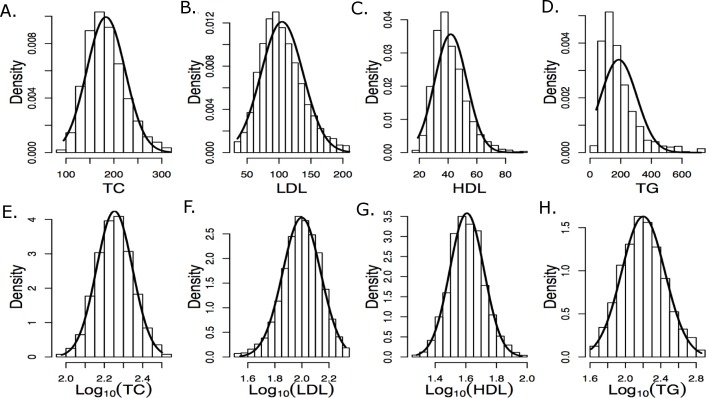
Histograms of raw and log10 transformed baseline lipid levelsNormal distributions computed using the baseline means and standard deviations are overlaid. (A–E) depict measured values and (E–H) depict log-transformed values.